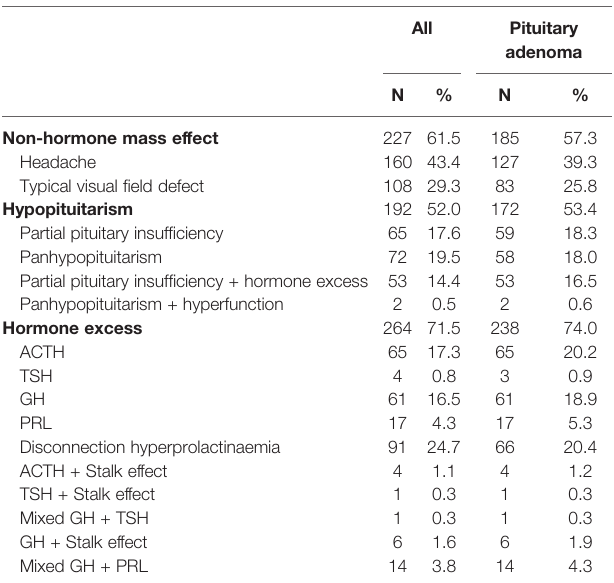
TABLE 2 | Presurgical signs and biochemical evaluation.